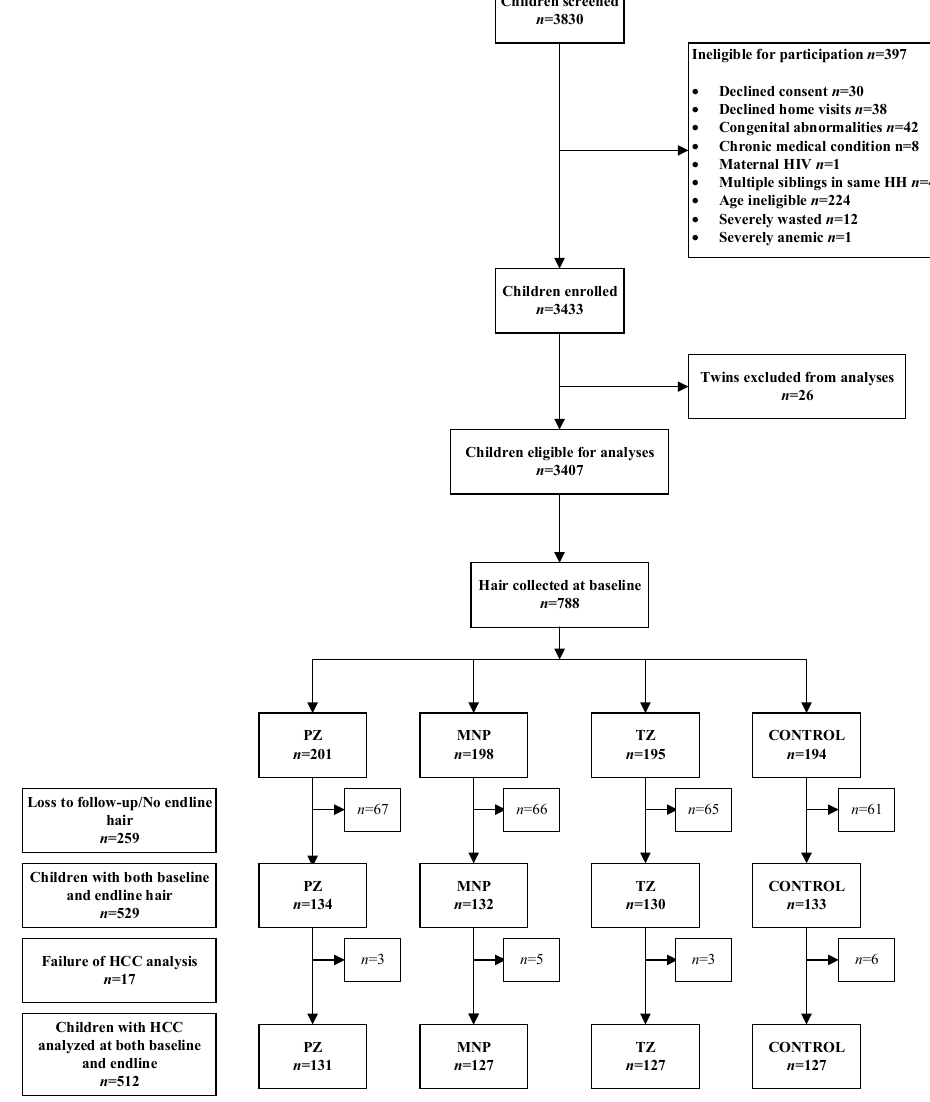
Figure 1. Lao Zinc study flow diagram for hair collection. MNP = Micronutrient powder; PZ = preventive zinc; TZ = Therapeutic zinc.